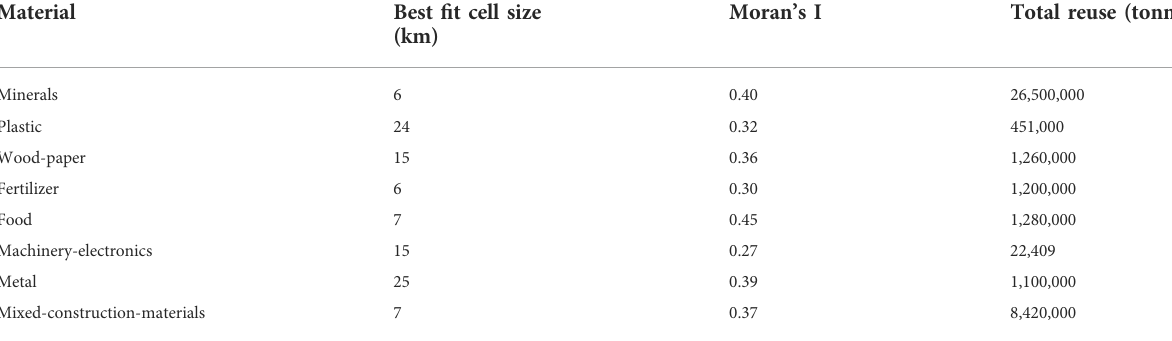
TABLE 1 Best fi t cell size, Moran ’ s I, and total reuse in tonnes of each material.